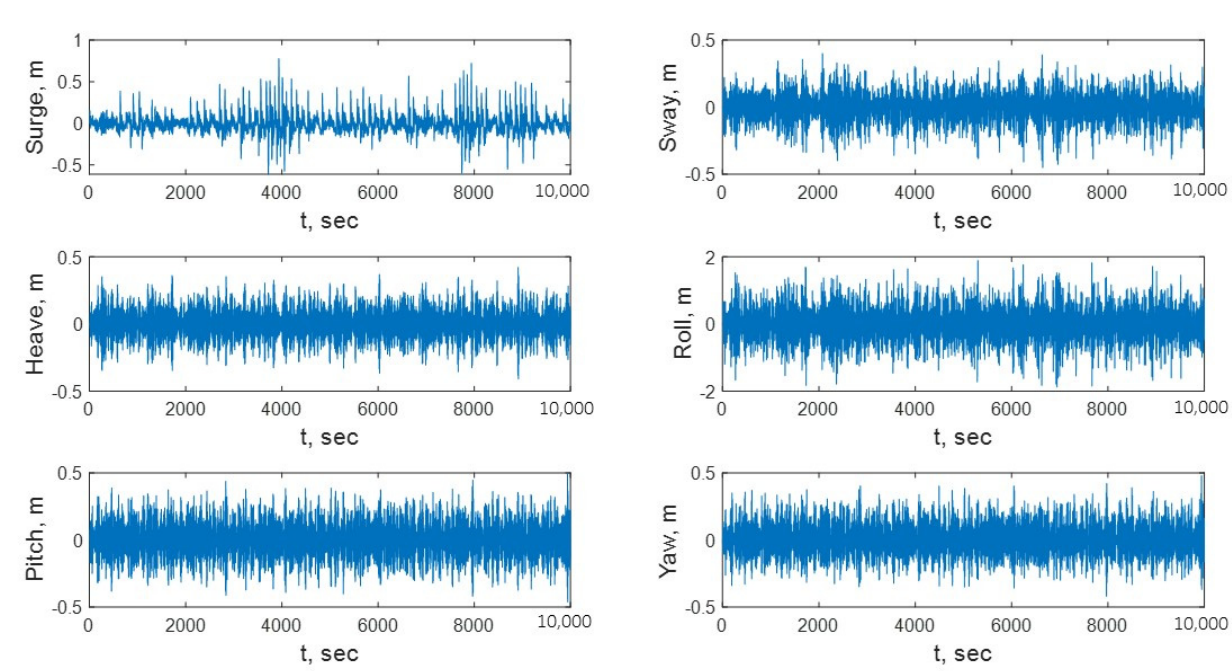
Figure A2. Load case c2 (H mo = 2.5 m)—wave frequency position. The surge and sway positions are relative to the position of the Delta, the other positions are absolute position of the ship.